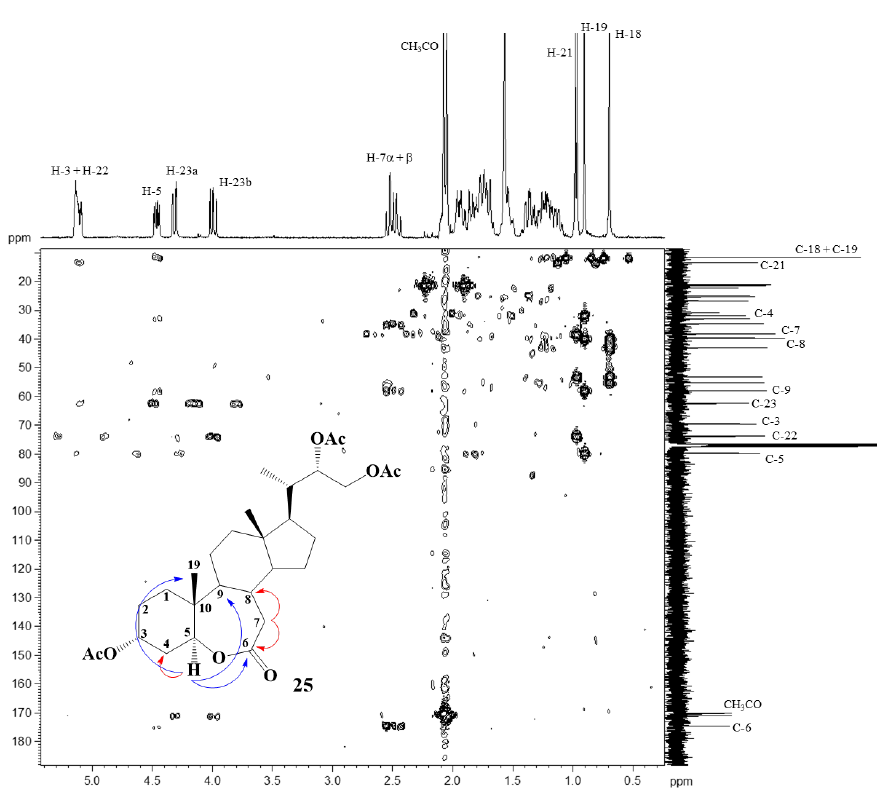
Figure 6. Inverse Detection Heteronuclear-Correlated 2D 1 H- 13 C HMBC Contour Plot, and Major 2 J HC (red) and 3 J HC (blue) Correlations Observed for Protons H-5α and H-7 of Compound 25 (6-oxalactone).